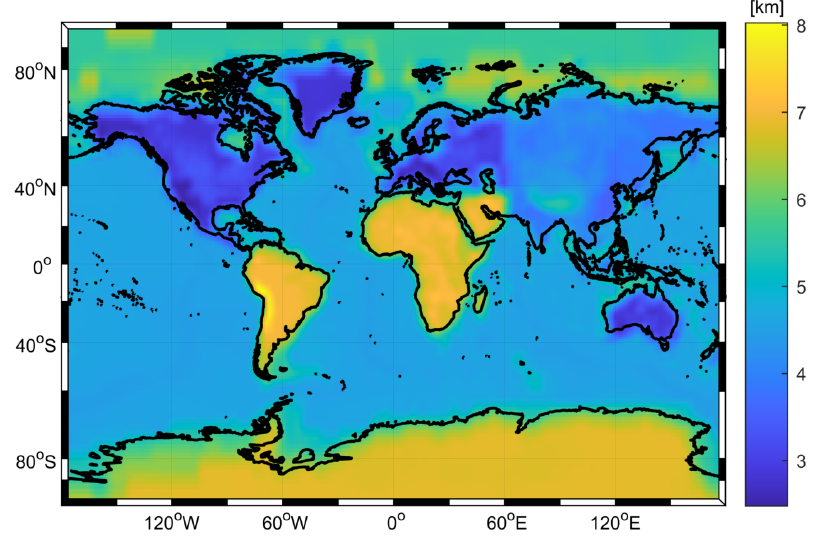
Figure 6. Standard deviation of the error of the input a priori seismic observations according to the CRUST2.0